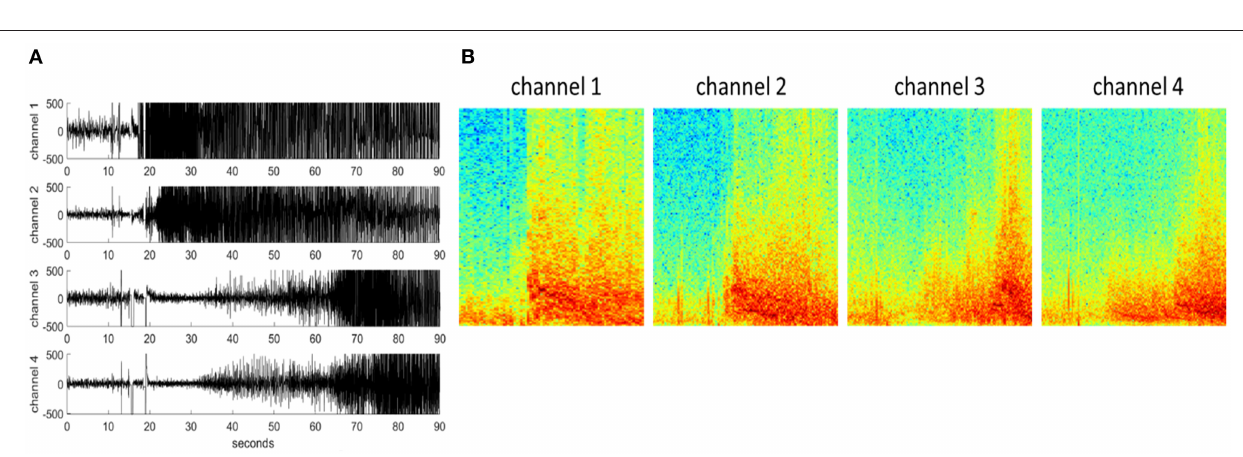
FIGURE 2 | (A) An example 4-channel time-series iEEG record. (B) 224 x 224 x 3 spectrogram images of each iEEG record